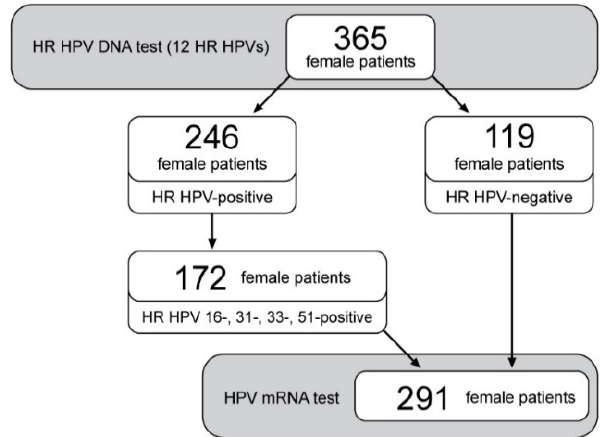
Figure 3. Flowchart presenting the study design. HR—high risk; HPV—human papillomavirus. Table 6. Analyses of E6/E7 mRNA HPV 16, 31, 33, and 51 in cervical samples.